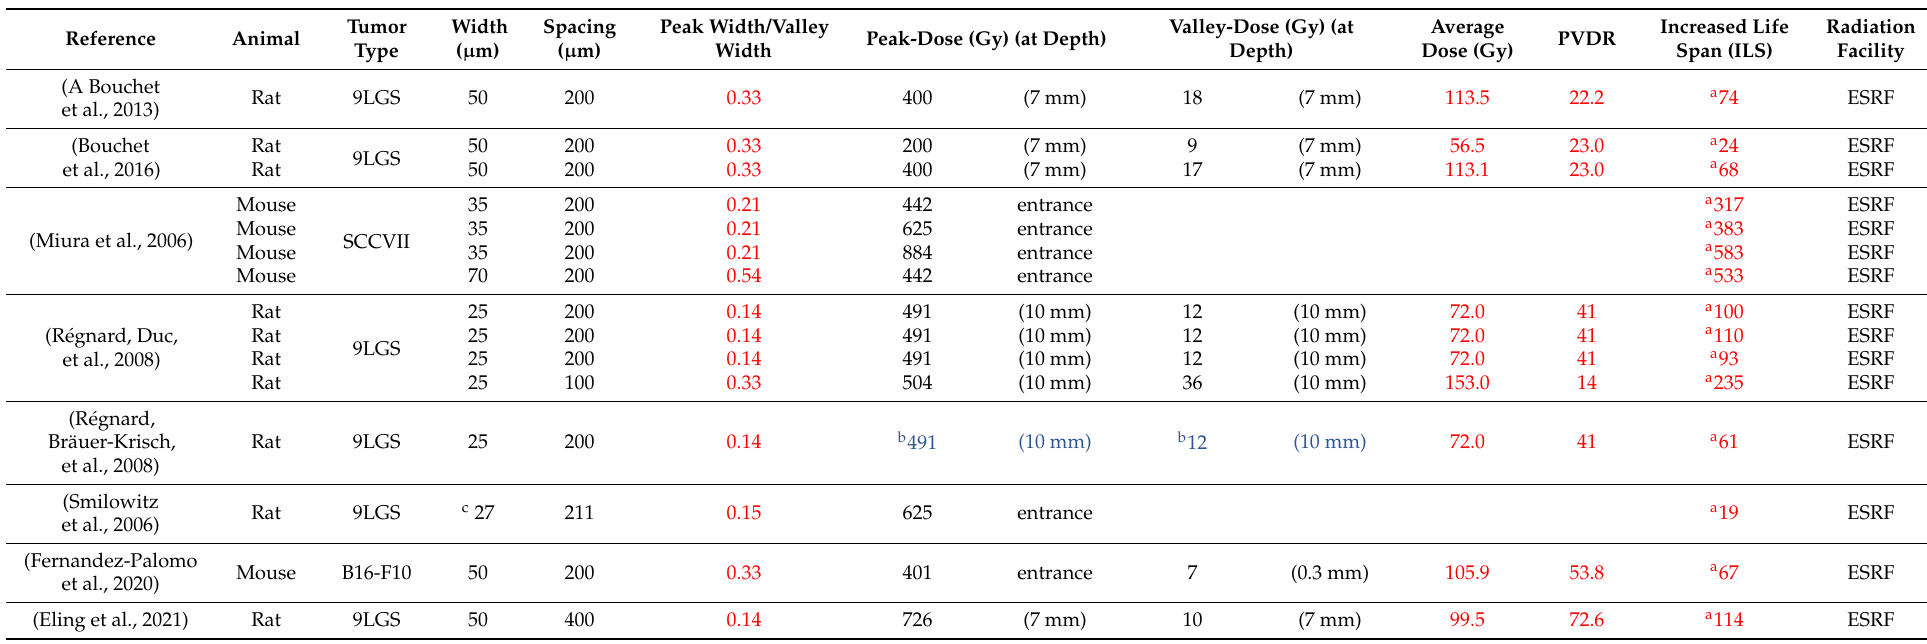
Table 1. MRT studies and their dosimetry parameters included in this